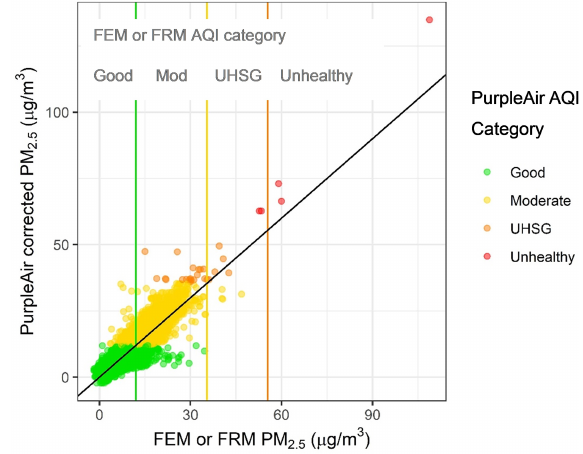
Figure 7. The 24h AQI categories as measured by the corrected PurpleAir and the FEM or FRM for the full dataset generated with the models built using the LOSO withholding